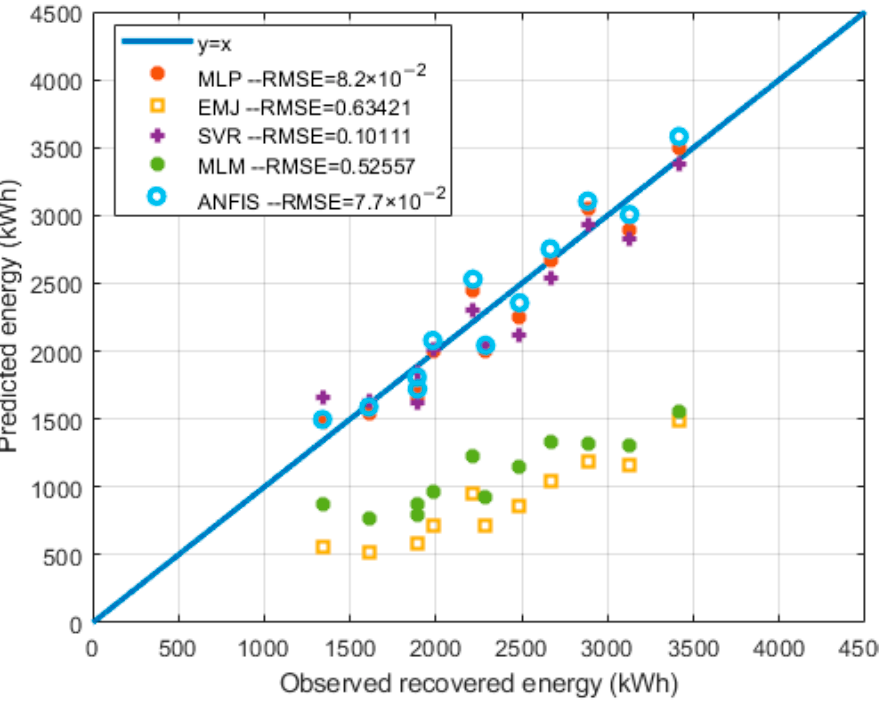
Figure 15. Correlation between observed and estimated recoverable energy on the site of Lomé.